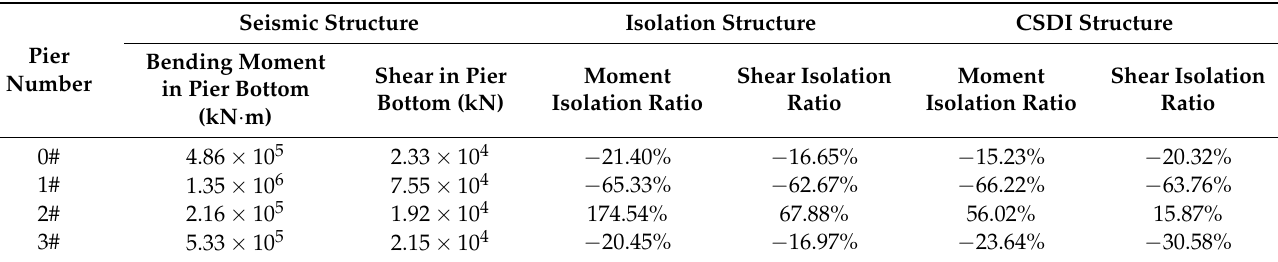
Table 3. Seismic response comparison of